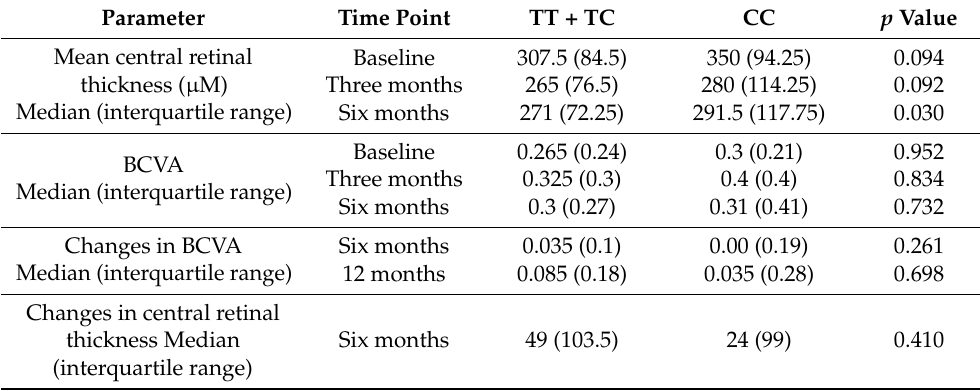
Table 8. CRT and BCVA associations with CYP4F2 rs2108622